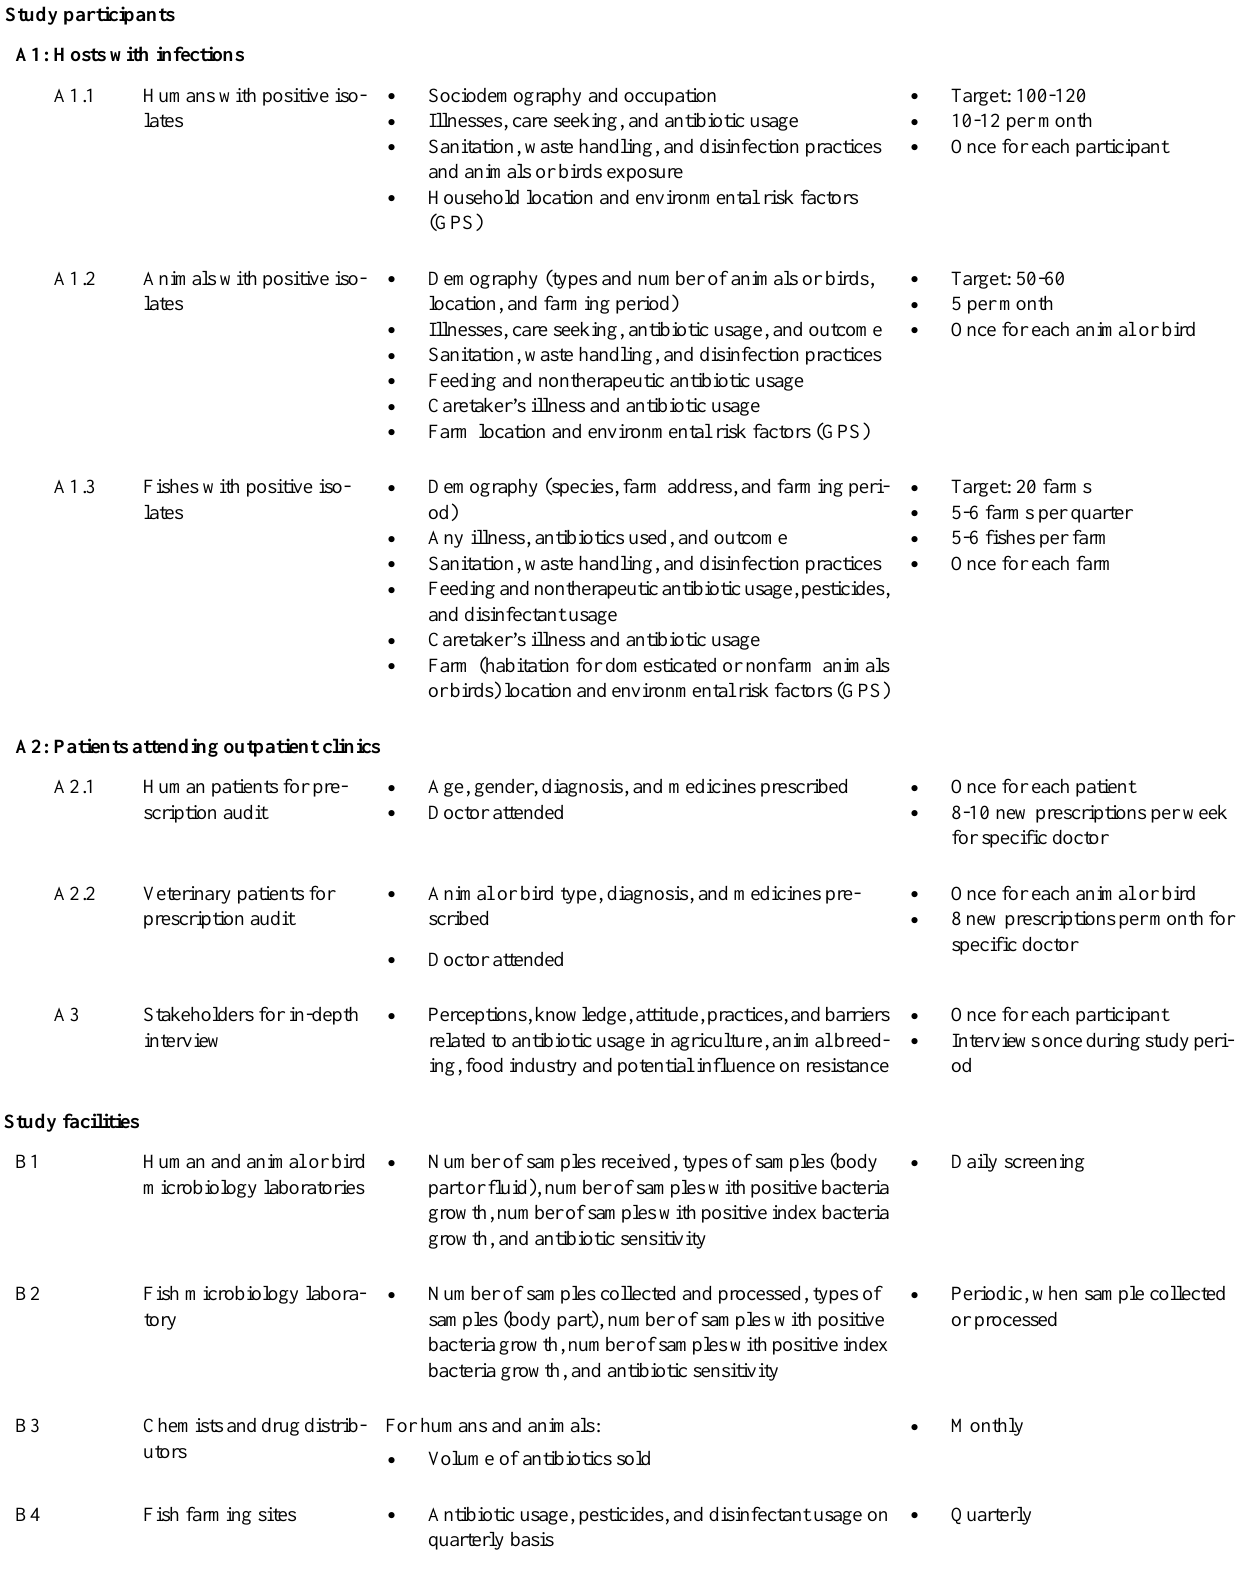
FrequencyData components to be collectedSerial no. and